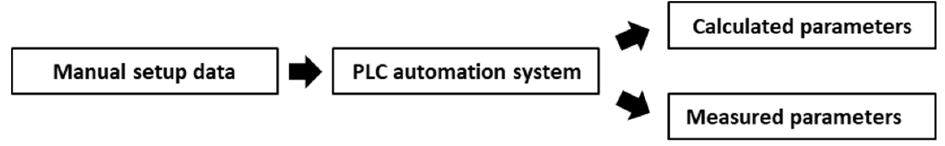
Figure 2. Data creation and acquisition fl ow.